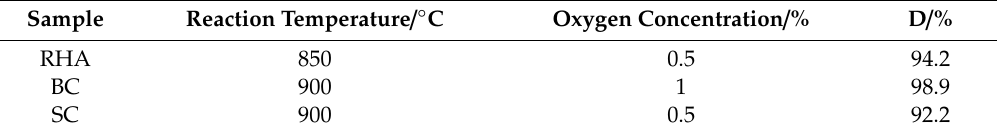
Table 2. Optimum reaction conditions and denitration rate of carbon